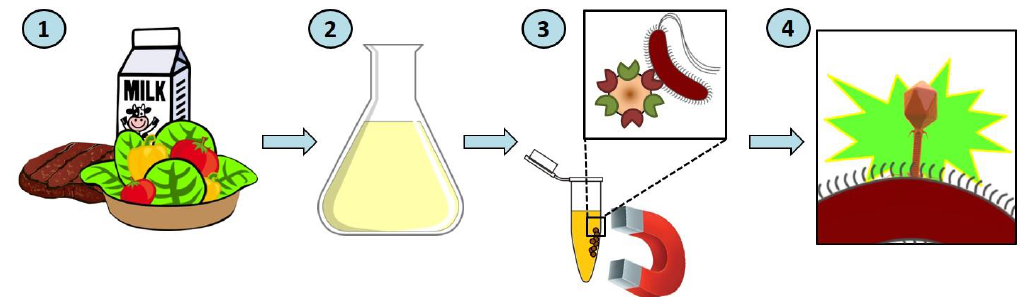
Figure 4. Schematic representation of the workflow of the combined CBD-MS/A511:: luxAB assay. ( 1 ) food sample; ( 2 ) selective enrichment; ( 3 ) CBD-based magnetic separation; ( 4 ) A511:: luxAB phage infection and generation of bioluminescent signal.